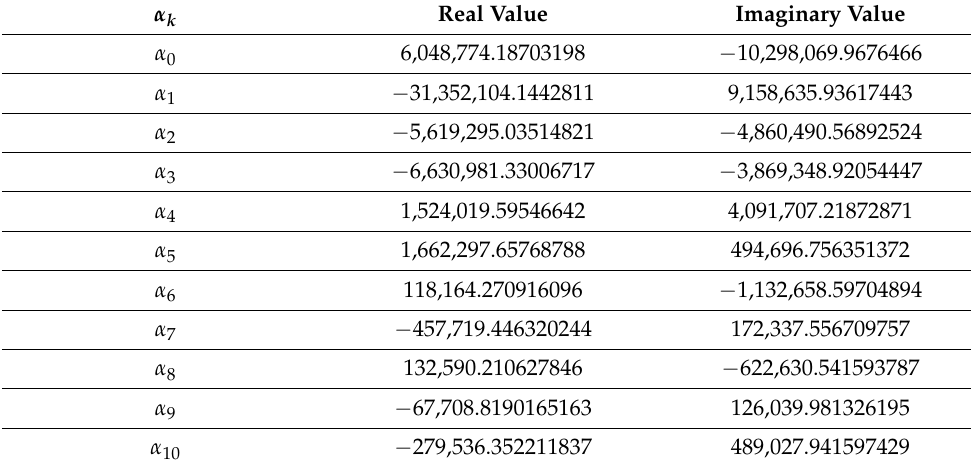
Table 3. The real values and imaginary values of the complex coefficients α k